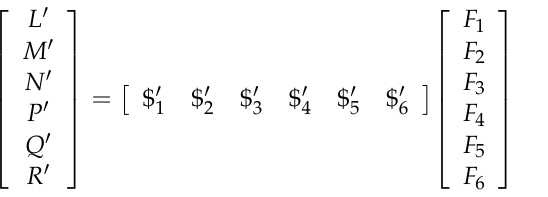
Figure 1. ( a ) The knee complex is represented by six constraints ($ (cid:48) collectively in equilibrium as indicated by their reciprocal conditions to the $ (at the ’ s). The original anatomic schematics and lines of action were published previously. ( b ) The velocity vector of the center of gravity (when the body is slightly disturbed) can only be in a horizontal direction, perpendicular to the gravity force line.